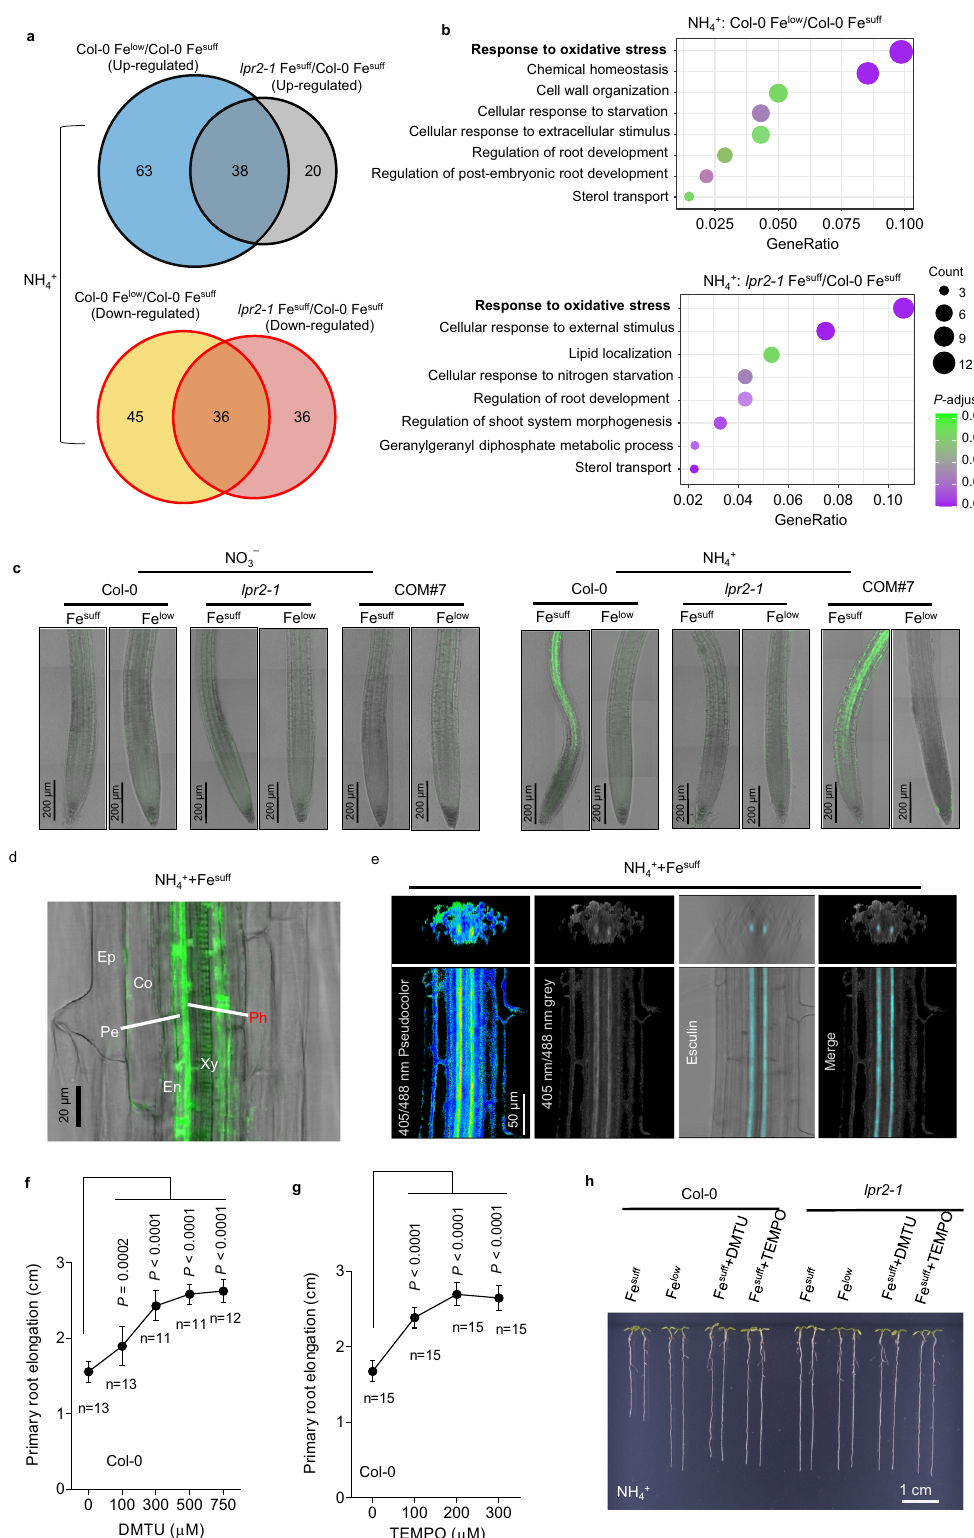
indirectly re fl ected by roGFP2-Orp1 reporter in its neighboring cells 29 . Consistent with the observed ROS formation, the roGFP2-Orp1 reporter showed that NH 4 + also triggered a burst of H 2 O 2 in root stele under Fe suff conditions (Supplementary Fig. 20). A close-up view of H 2 DCFDA-stained roots revealed that the NH 4 + -triggered burst of ROS mainly occurred in